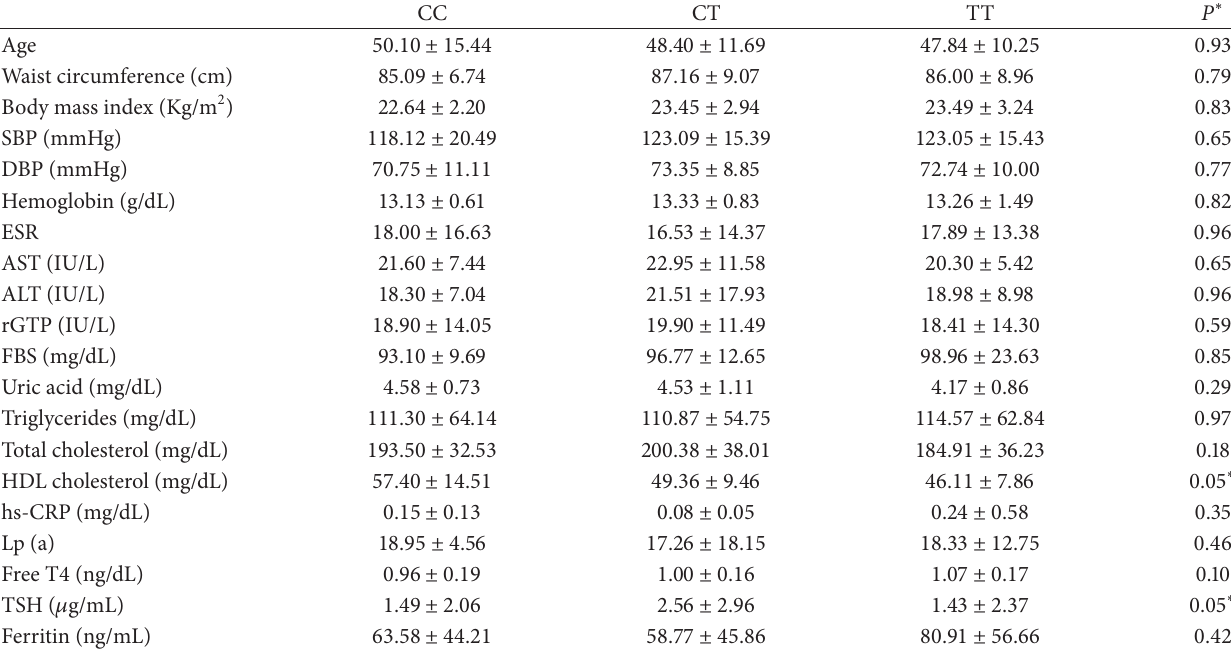
Table 3: Risk factors for atherosclerosis according to female gender.